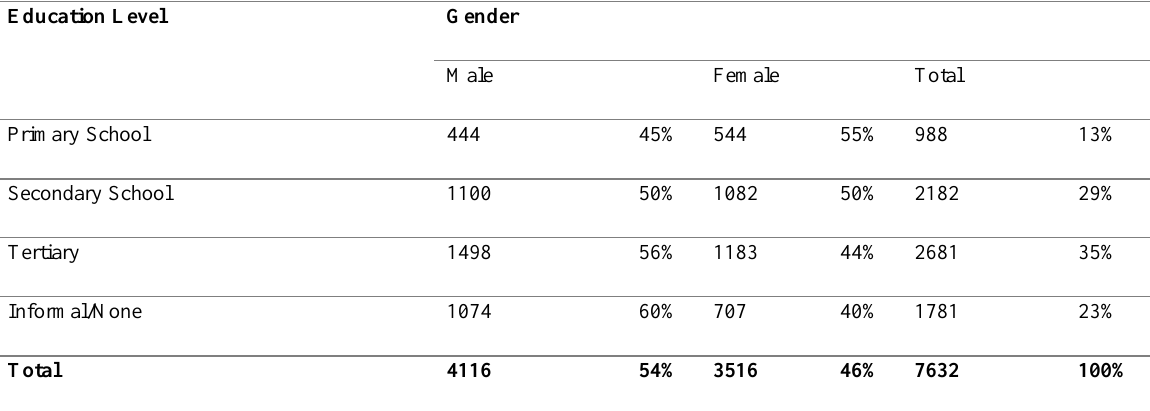
Table 3: Citizen's highest level of education by sex